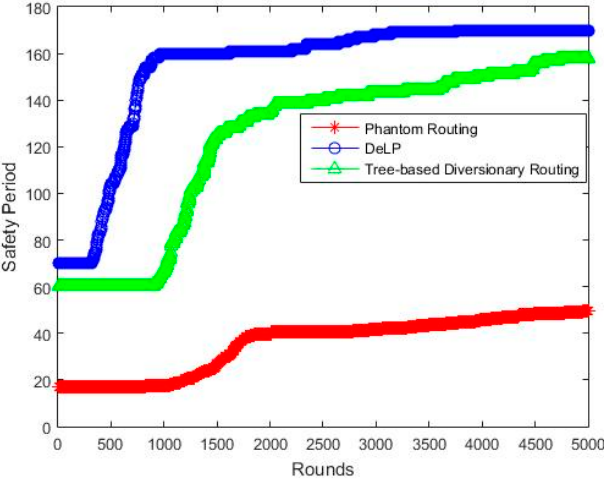
Figure 12. Safety period time Vs Network lifetime (rounds). Table 4. Comparison of safety period after equal intervals.